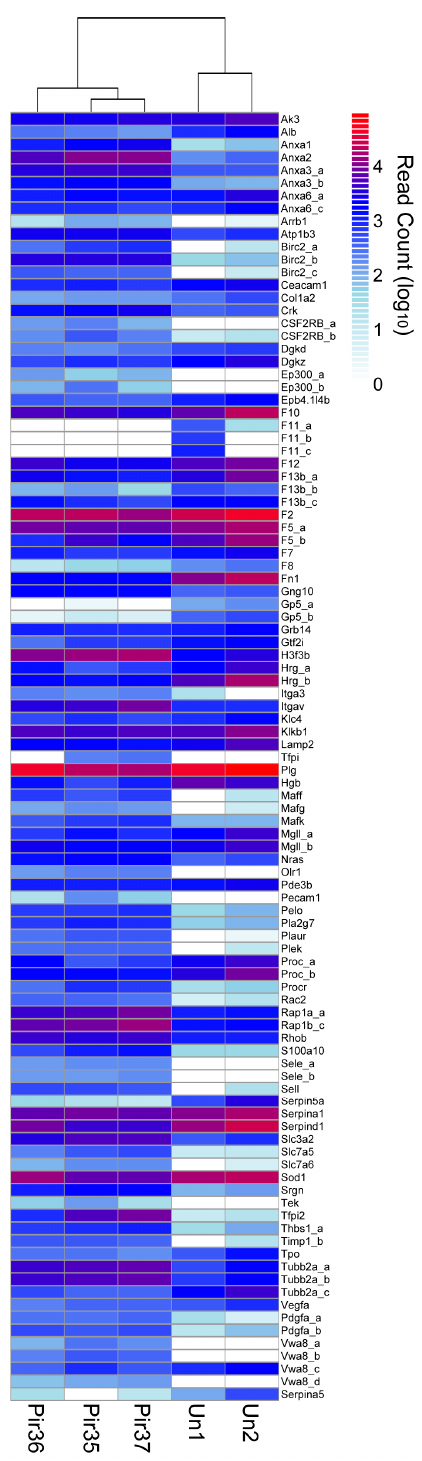
Figure 4. Differentially expressed hemostatic response transcripts (DETs). General innate immune response and cytokine signaling. Differential expression (DESeq) data was plotted by cluster analysis with R software (pheatmap, https://cran.r-project.org). Infected (Pir35, Pir36, Pir37) and uninfected (Un1, Un2) hamster livers. Histogram shows read count densities (log10) for 195 transcript isoforms or alleles from 153 unique genes.